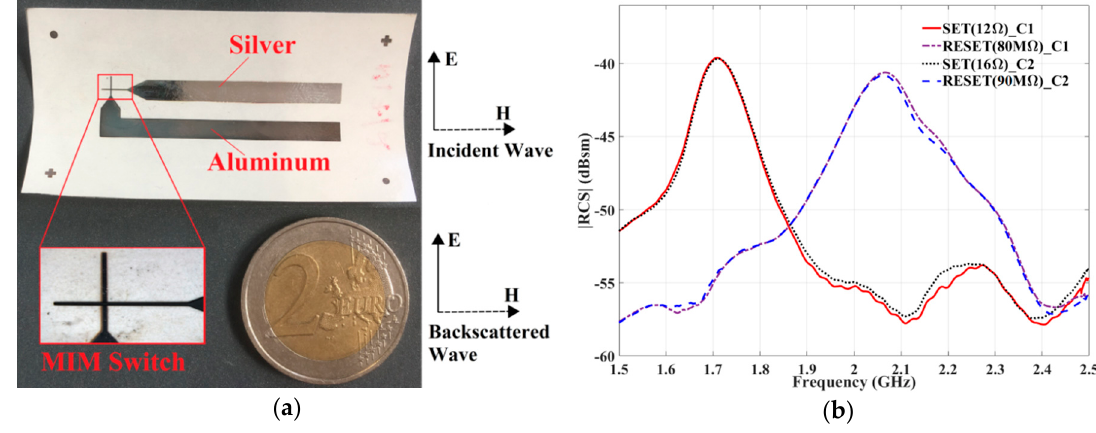
Figure 10. Photograph ( a ) and measured |RCS| response ( b ) of the reconfigurable RF-tag on paper substrate.